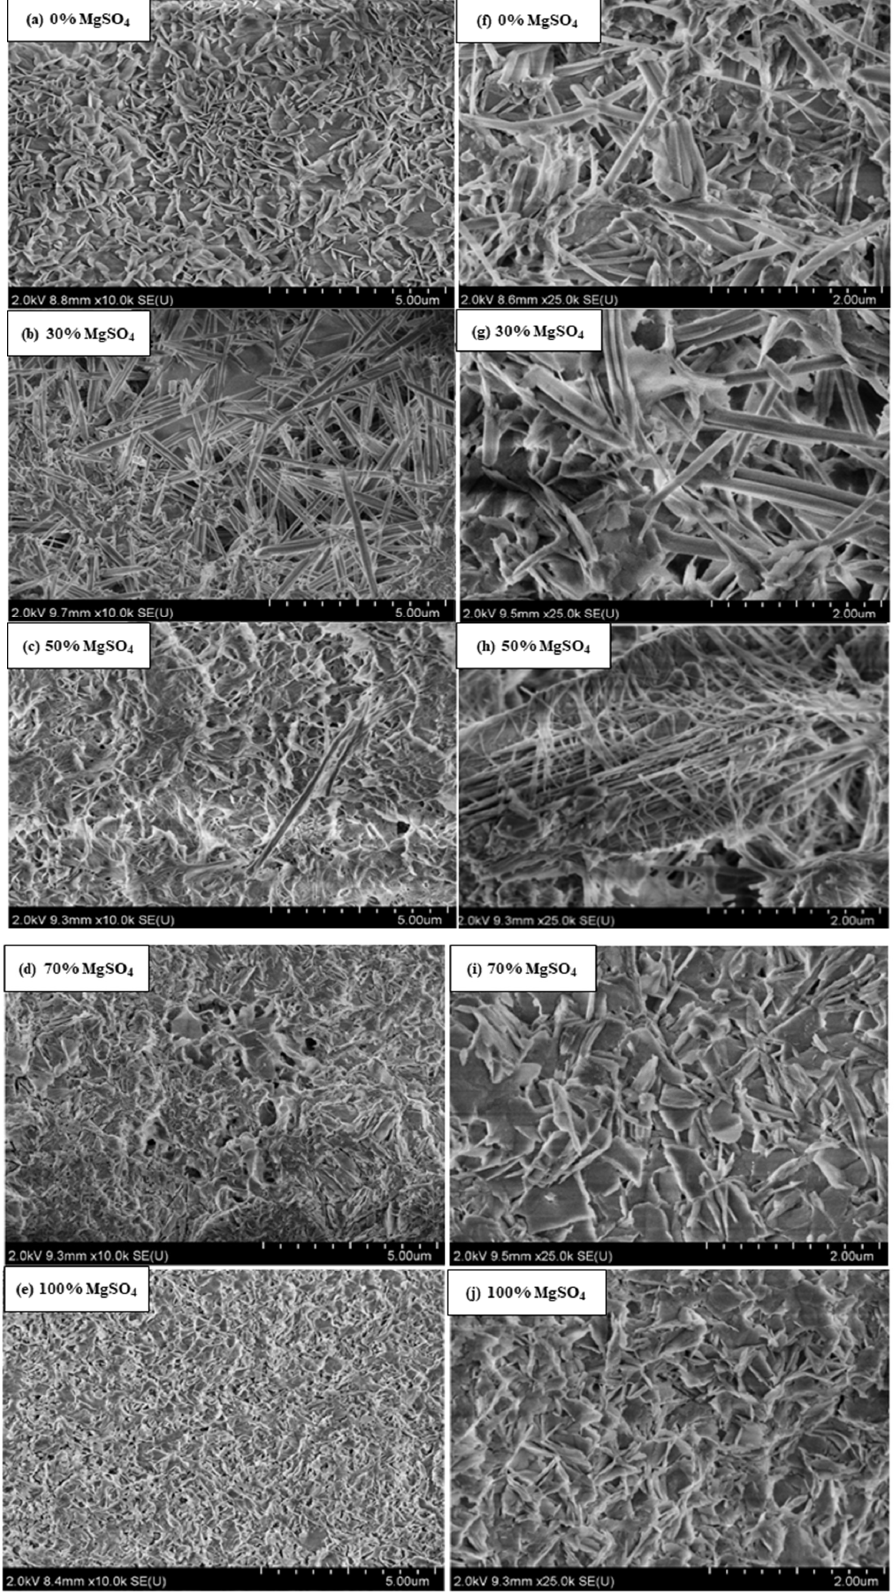
Figure 7. The SEM images of cement with different mass fractions of MgSO 4 after air curing for 28 days. 28